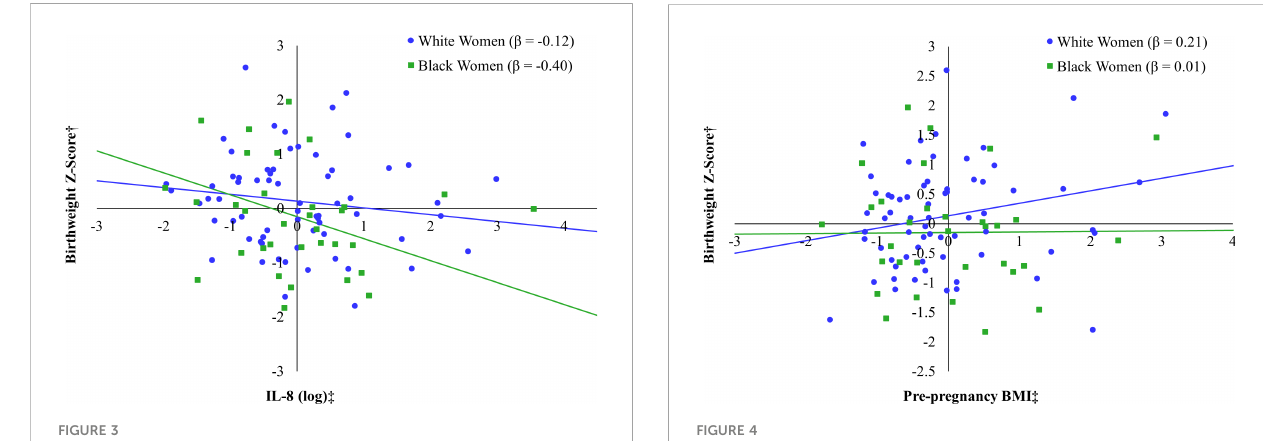
FIGURE 4 Relation between pre-pregnancy BMI and birthweight Z-score by race*. *Models additionally adjusted for maternal age at the prenatal visit, maternal education, IL-8 (log-transformed), and PGH